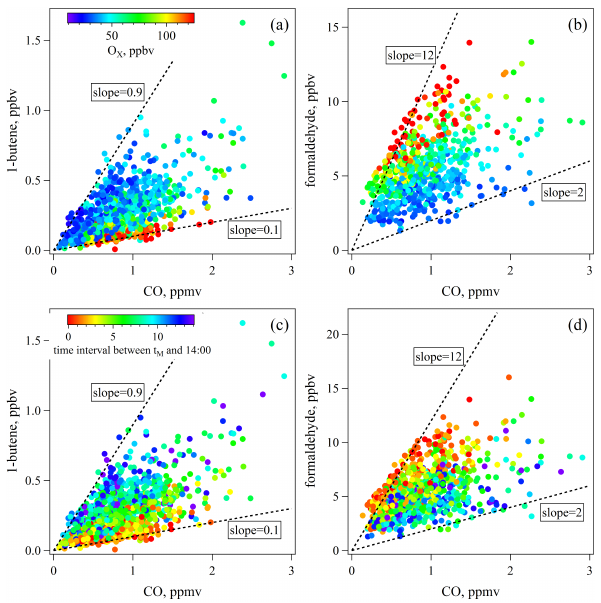
Figure 4. Scatter plots of (a, c) 1-butene and (b, d) formaldehyde vs. CO measured at the PKU site during August–September 2011. Data points in (a) and (b) were colored according to O x (O 3 + NO 2 ) levels, while data points in (c) and (d) were colored according to time intervals between measurement time ( t M ) and